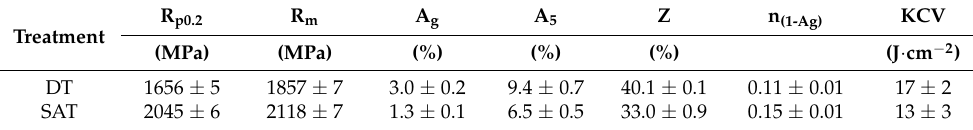
Table 2. Results from mechanical property testing of DT and SAT samples.